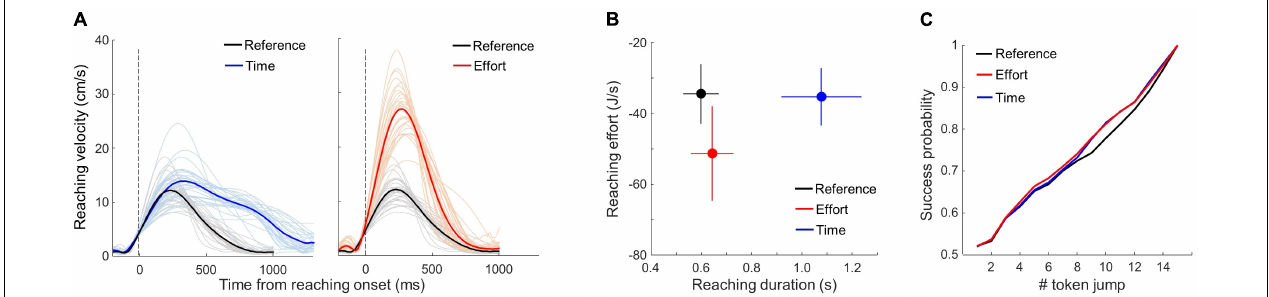
FIGURE 2 | Control analyses. (A) Individual (thin) and average (bold) reach velocity profiles in the three motor conditions of the choice task, aligned on movement onset. Only adequate movements are included. Time and Reference conditions are compared in the left panel; Effort and Reference conditions are compared in the right panel. (B) Relationship between the average ( ± SD) reaching duration and effort across subjects in the three motor conditions (see Eq. 2 and details in text). (C) Average success probability profiles of trials experienced by subjects in each of the three motor conditions (Eq.